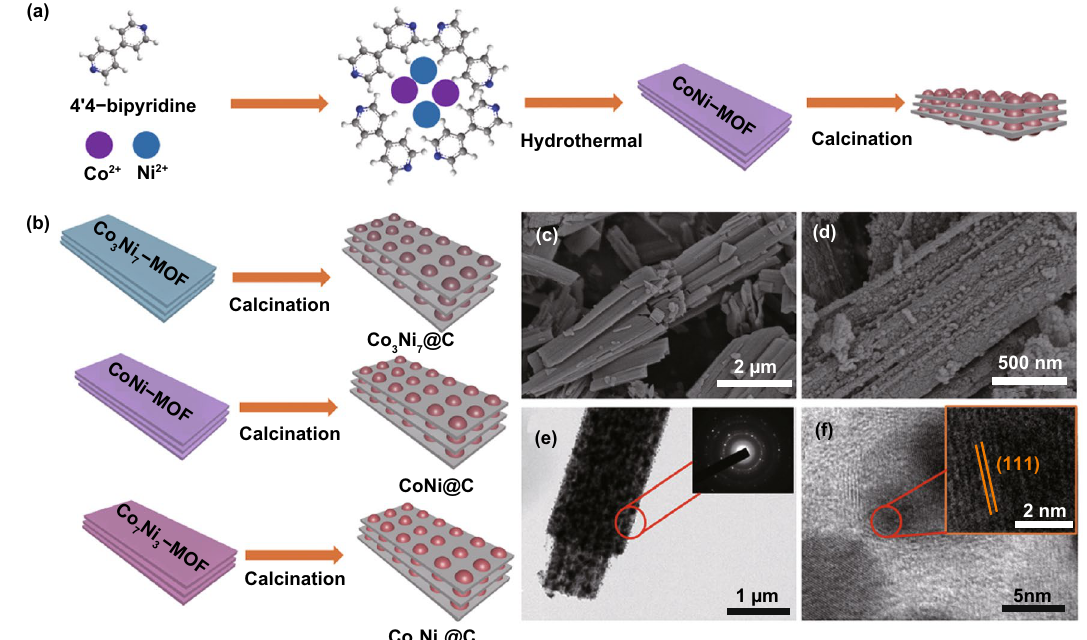
Fig. 1 a , b Schematic diagram process for forming of Co x Ni y @C. c SEM picture of CoNi-MOF. d SEM picture of Co 3 Ni 7 @C nanosheets. e , f TEM and HRTEM of